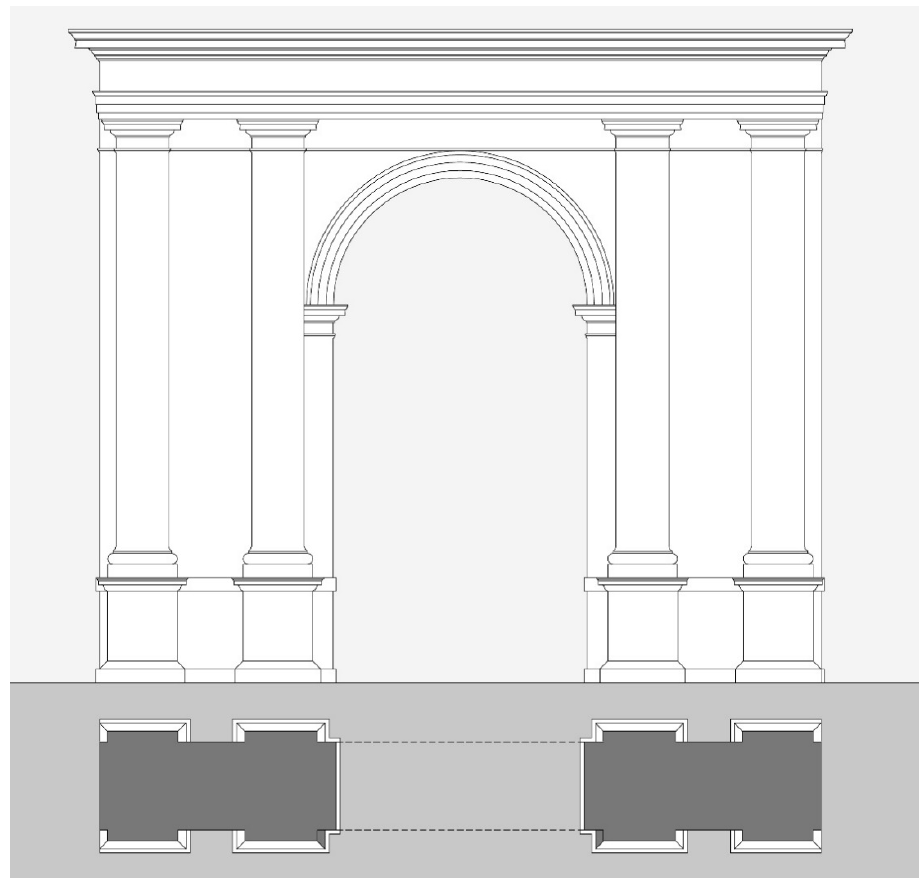
Figure 16. Plan and elevation of the Triumphal Arch to be inserted in Raffaello’s The Disputa after the restitution plan of the pylon.